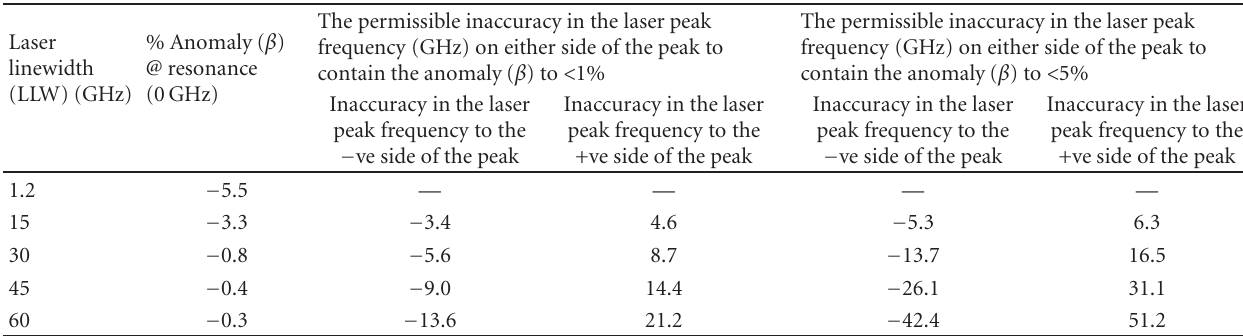
Table 2: A table of theoretically computed percentage anomalies for various laser linewidths.